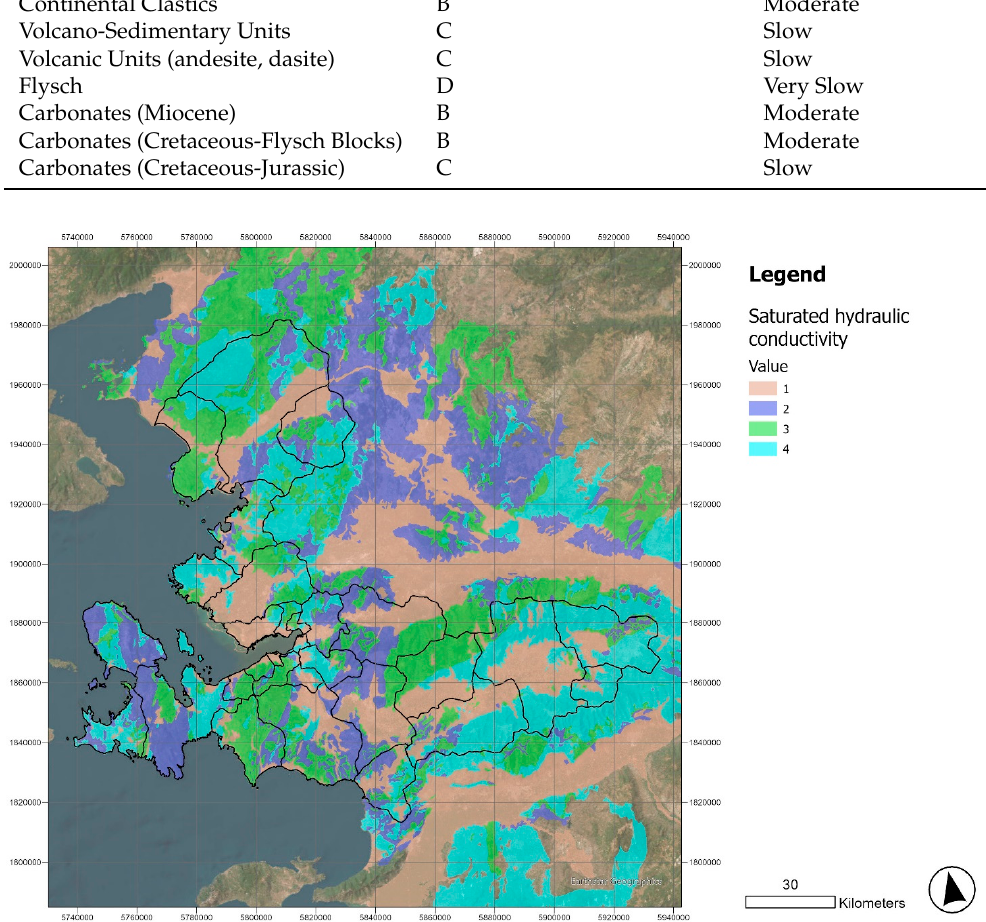
Figure 3. Raster map of soil hydrologic group. Source: group classification of geological units around İ zmir made by Salata and Uzelli 2022.